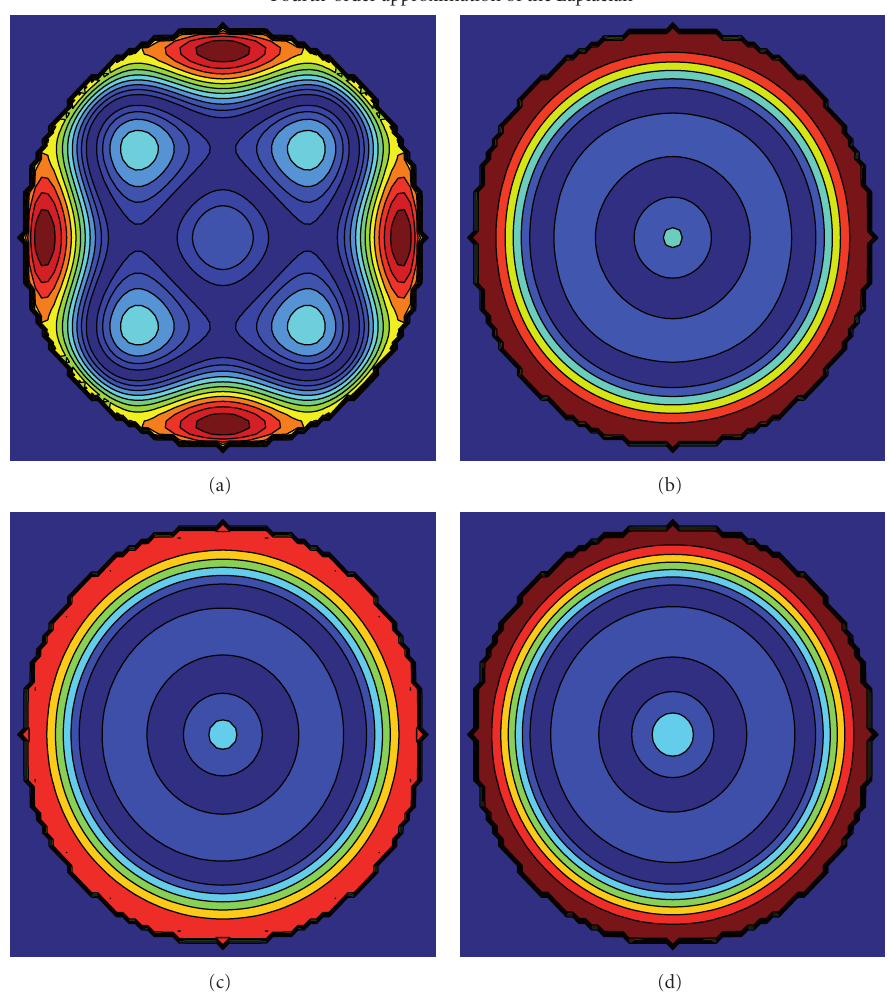
Figure 4: See the caption of Figure 3. The anisotropic error for (a) the standard nine-point stencil and the isotropic errors for (c) (45) with D2V37 and (d) Patra and Karttunen ( 𝑐 1 = 0 ) conform with the theoretical predictions. The error for (b) (43) with D2V37 is isotropic: this is not in accordance with the prediction from (37). The colors are not scaled between the